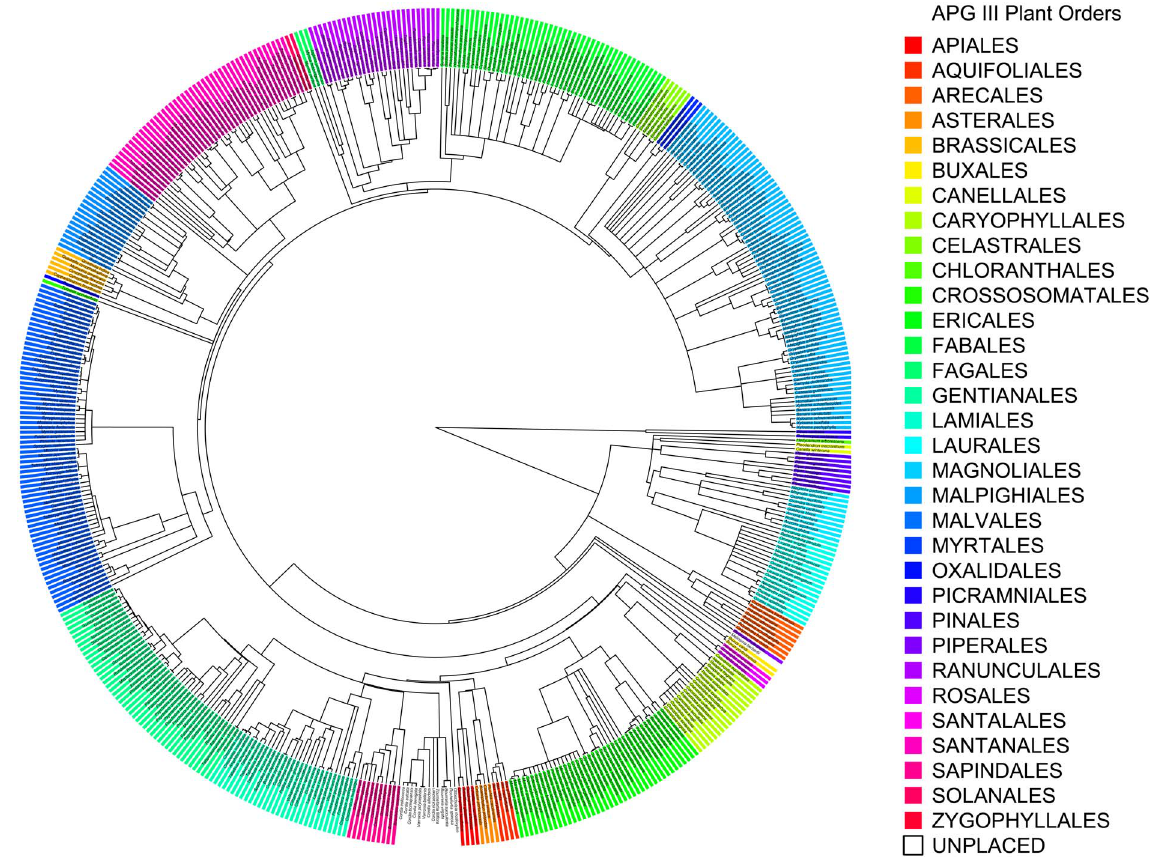
Figure 2. A maximum likelihood phylogeny constrained at the ordinal level representing 526 native and naturalized tree species of Puerto Rico (the single tree fern in the phylogeny is excluded to aid visualization). Ordinal placement according to APG III [60] is color coded.